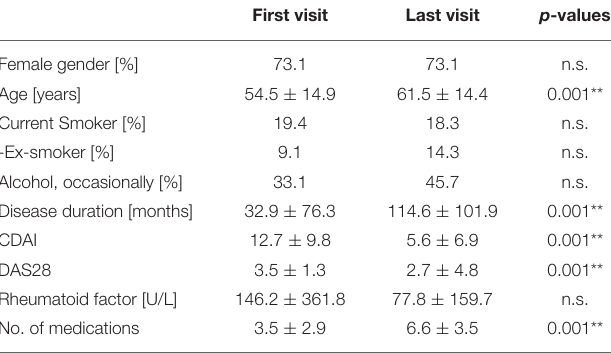
TABLE 3 | Patient’s demographics, disease characteristics and medications at first and last visit (including on request medication, descriptive statistics include means, and standard deviations; percentages in parentheses calculated from total